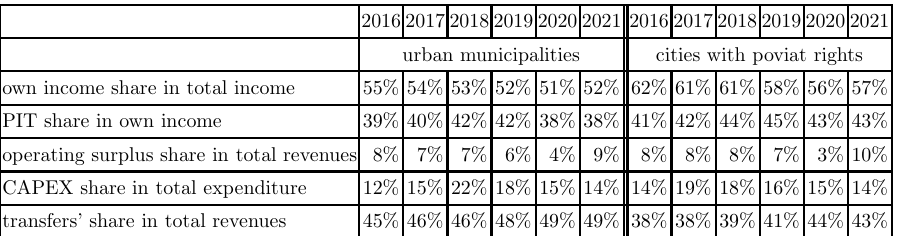
Table 3 Indicators of the financial condition of local government